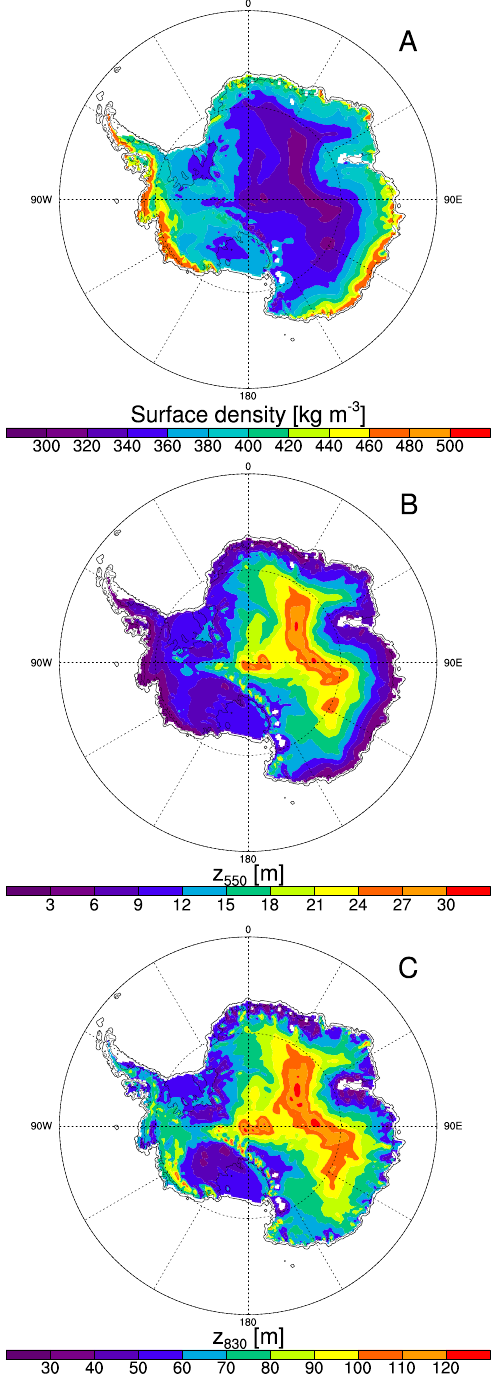
Fig. 7: Modelled surface density (A) and depths of the crit- ical density levels ρ = 550 kg m − 3 (B) and ρ = 830 kg m − 3 (C)